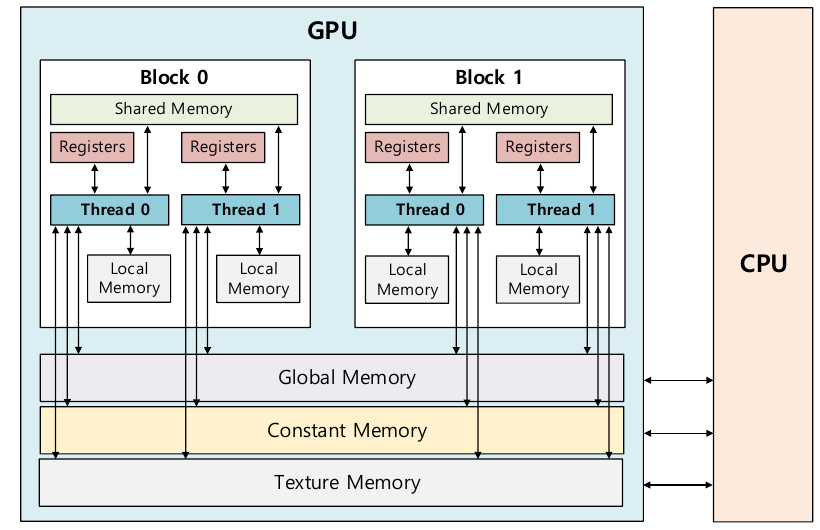
Figure 7. Memory structure of GPU